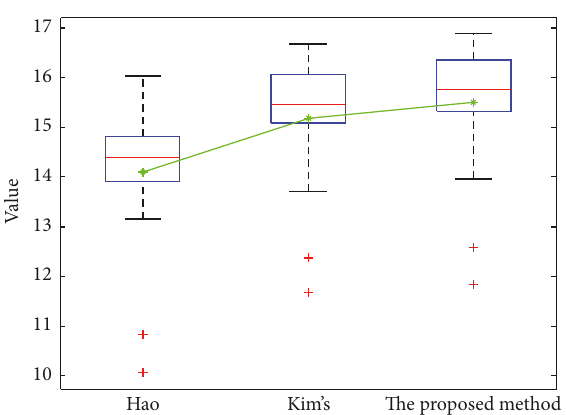
Figure 13: IE results by Hao’s, Kim’s, and the proposed method. 20406080100120140160180200